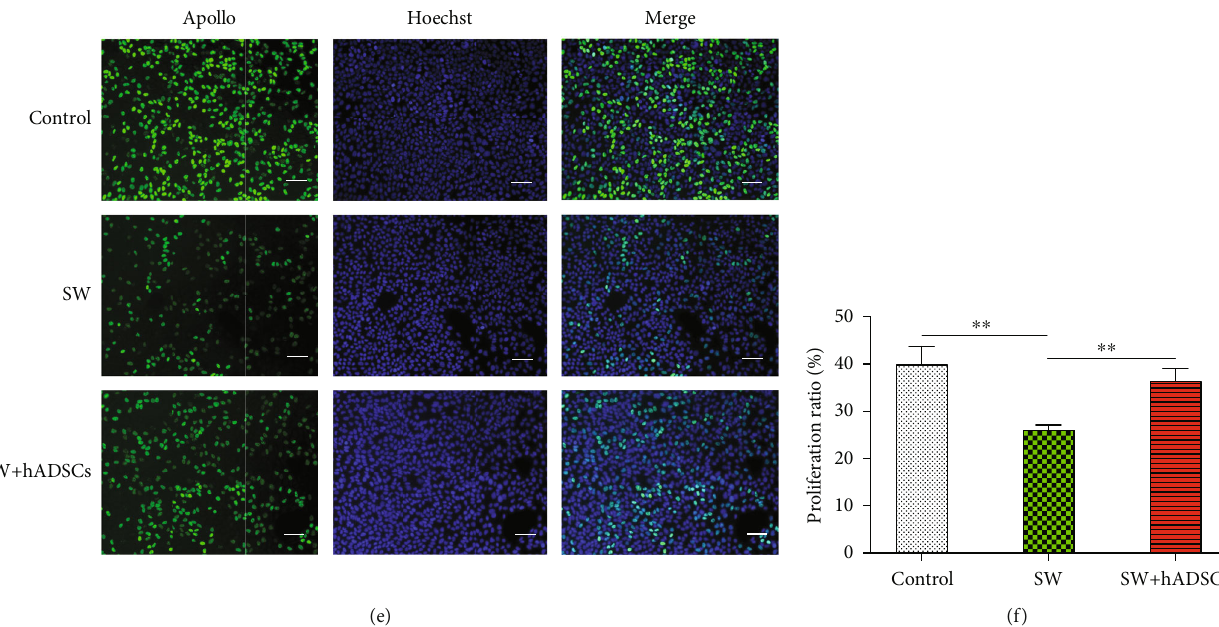
Figure 2: E ff ect of hADSCs on the proliferation and migration of SW-treated cells in vitro . CCK8 assay results showed that the proliferation of HaCaT cells was signi fi cantly inhibited following exposure to 3.5% salt concentration (a). Transwell coculture system schematic (b). The cell scratch test (c) showed that the SW group showed a signi fi cant closure delay at the 12th hour compared with the control group, and the hADSC coculture reduced the e ff ect of SW on cell migration ability and signi fi cantly promoted cell migration (d). Proliferating HaCaT cells were stained with green fl uorescence, and all nuclei were stained with blue fl uorescence (e). The results of the EdU assay showed that the cell proliferation rate in the SW group was signi fi cantly inhibited compared with that in the control group and the SW+hADSC group (f). Scale bars indicate 100 μ m. ∗ P < 0 : 05 , ∗∗ P < 0 : 01 , and ∗∗∗ P < 0 : 001 .